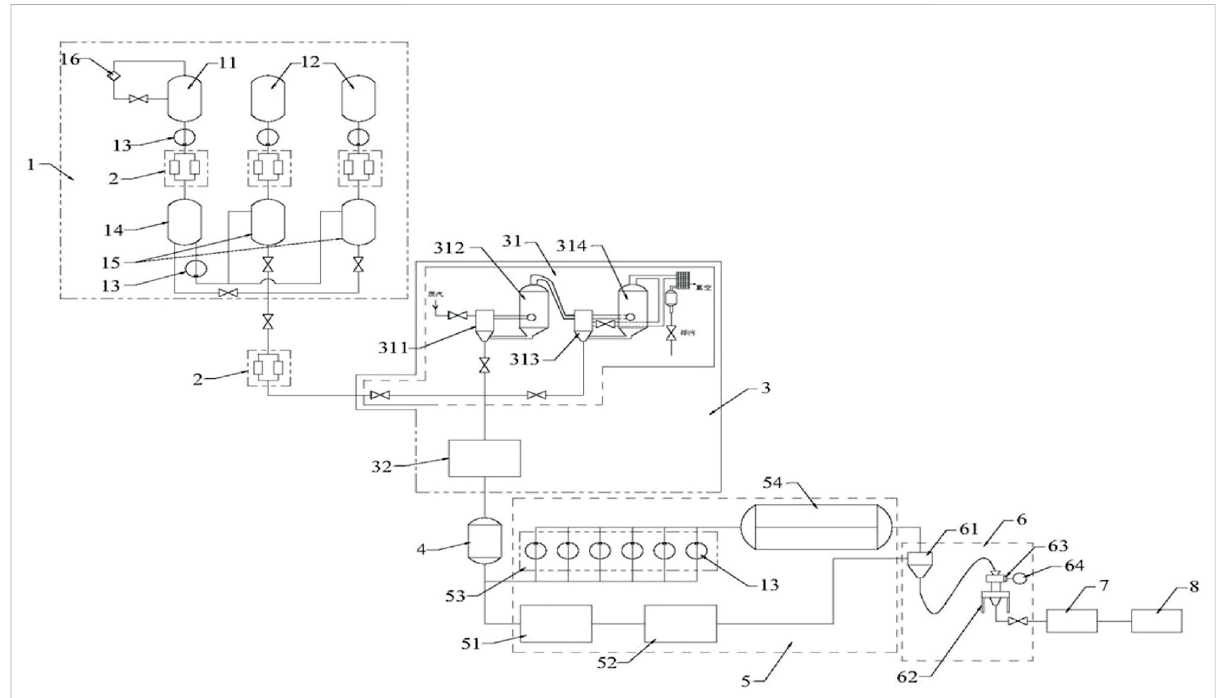
FIGURE 1 Structure layout diagram of the automatic production line of ZFTG. Description of reference numeral: 1. a liquid medicine extracting device; 2. double fi lter;3. concentration device; 4. ingredient tank; 5. drying device; 6. acrushing device; 7.mixing device; 8. automatic packaging device; 11.a fi rst extraction tank; 12. a second extraction tank; 13. transfer pump; 14. a fi rst liquid storage tank; 15. a second liquid storage tank; 16. oil-water separator; 31. double-effect concentrator; 32. spherical scraper concentrator; 311. a single-effect heating chamber; 312. a primary-effect evaporation chamber; 313. two-effect heating chamber; 314. two-effect evaporation chamber; 51. trough mixer; 52. vacuum drying oven; 53. coating device; 54. vacuum belt drier; 61. mixing hopper; 62. crusher; 63. fi ltration device; 64. vacuum pump. Patent application number: CN 215133530 U.